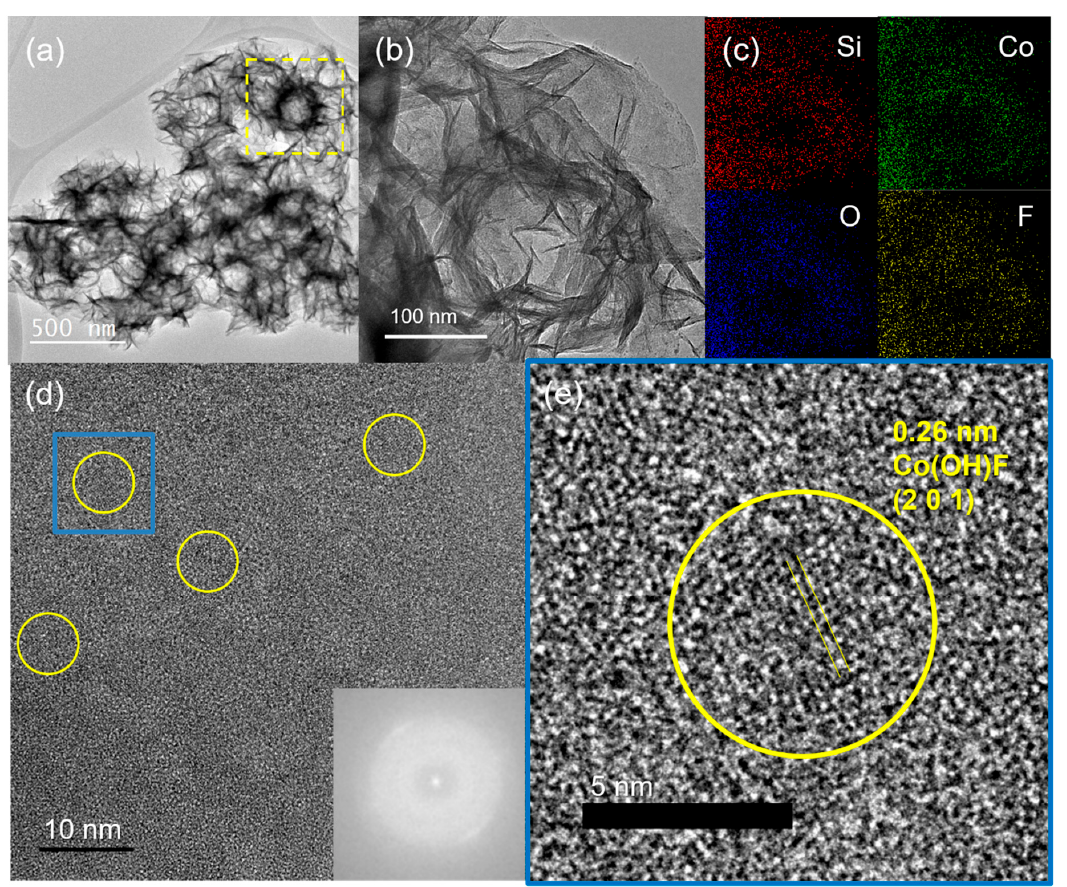
Figure 4. Transmission Electron Microscopy (TEM) analysis of the Co(OH) x F 2 − x nanosheets: ( a , b ) bright-field images, ( c ) electron dispersive spectroscopy (EDS) mapping, and ( d , e ) high-resolution images. An inset image in (d) is a FFT (Fast Fourier Transform) pattern of the high-resolution image.